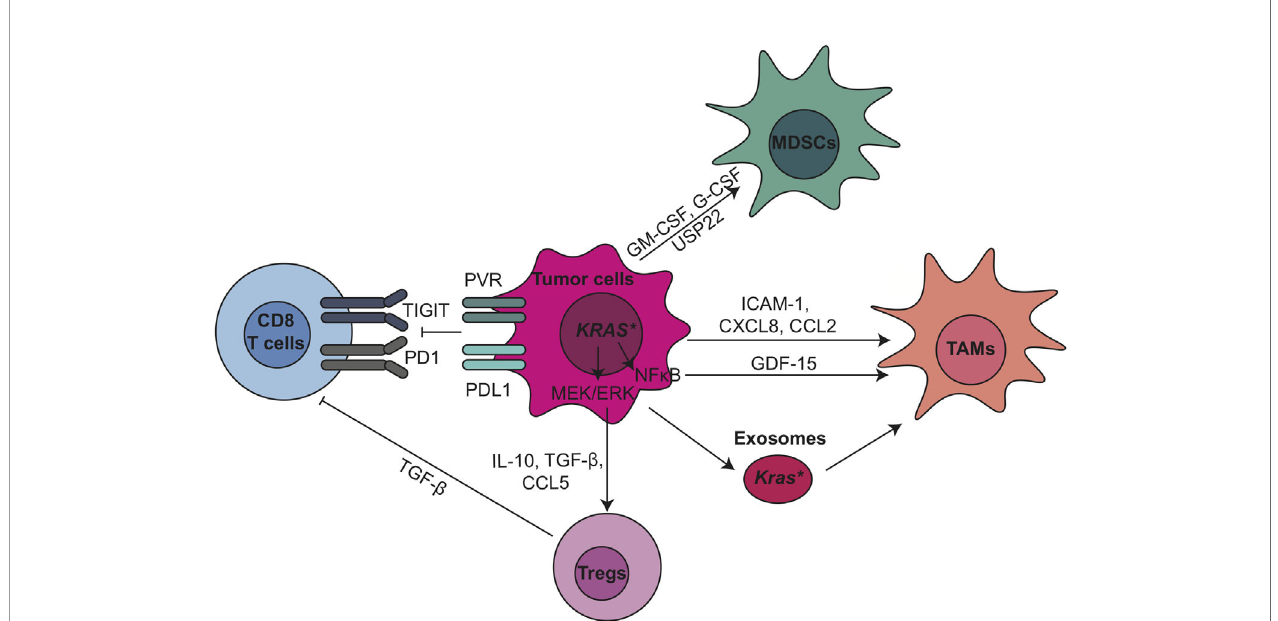
FIGURE 1 | Tumor epithelial cells modulate immunosuppressive tumor microenvironment through oncogenic pathways and immune checkpoint pathways in PDA. CCL, C-C motif chemokine ligand; CXCL, C-X-C motif chemokine ligand; ERK, extracellular signal-regulated kinase; G-CSF, granulocyte-colony stimulating factor; GDF-15, growth/differentiation factor-15; GM-CSF, granulocyte-macrophage colony-stimulating factor; ICAM-1, intercellular adhesion molecule 1; MDSCs, myeloid- derived suppressor cells; MEK, mitogen − activated protein kinase kinase; NF- k B, nuclear factor kappa B; PD-1, anti-programmed cell death 1; PD-L1, programmed cell death ligand 1; PVR, poliovirus receptor; TAMs, tumor associated macrophages; TGF- b , transforming growth factor b ; TIGIT, T cell immunoreceptor with Ig and ITIM domains; Tregs, regulatory T cells; USP22, ubiquitin speci fi c peptidase